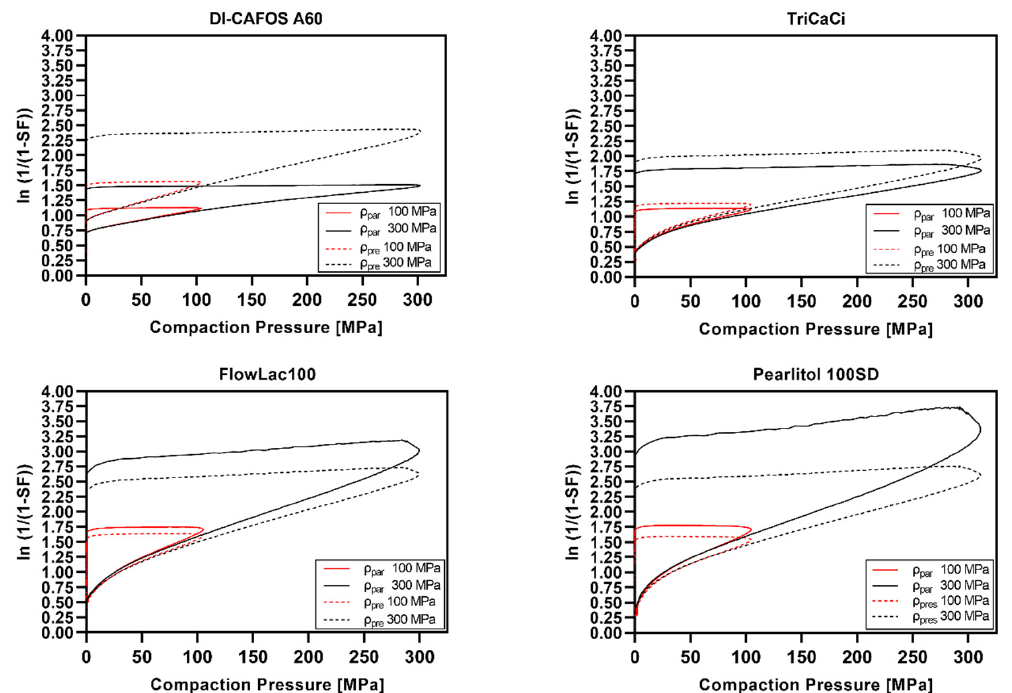
Figure 10. Heckel plots of nonpolymeric excipients at 100 and 300 MPa calculated using particle density ( ρ par ) or density under pressure ( ρ pre ).